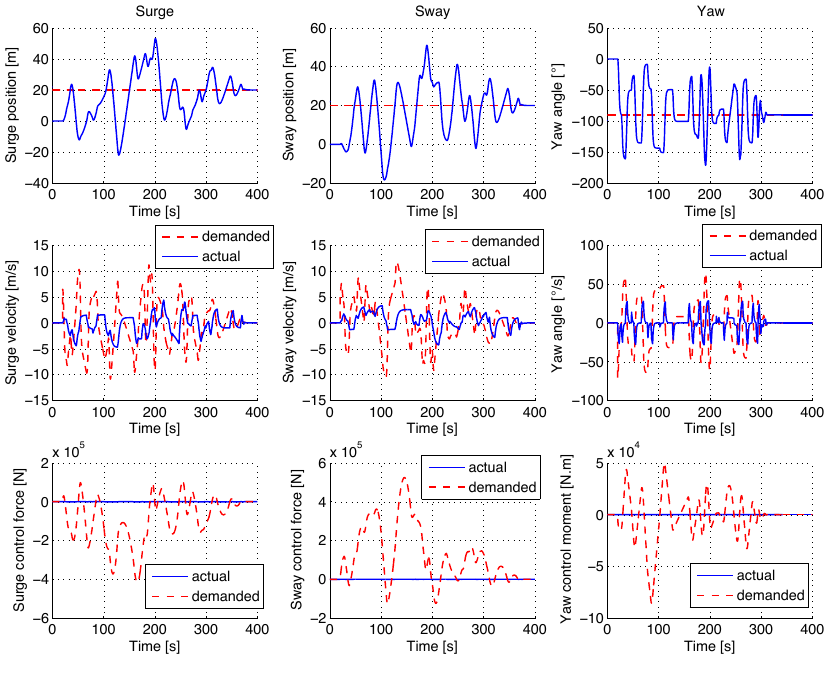
Figure 9: Performance of vehicle position regulation controller in current and position set point change, for the case where the anti-windup is not active.